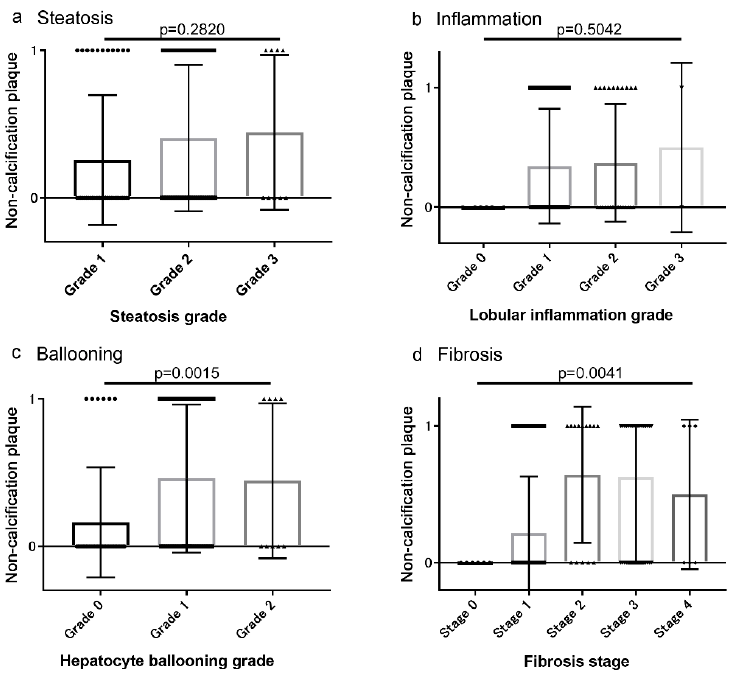
Figure 4. Association between non-calcified plaques and histologic characteristics ( a ) Steatosis, ( b ) inflammation, ( c ) Ballooning, and ( d ) Fibrosis. The presence of non-calcified plaques was positively correlated with the hepatocyte ballooning grade and the stage of liver fibrosis.